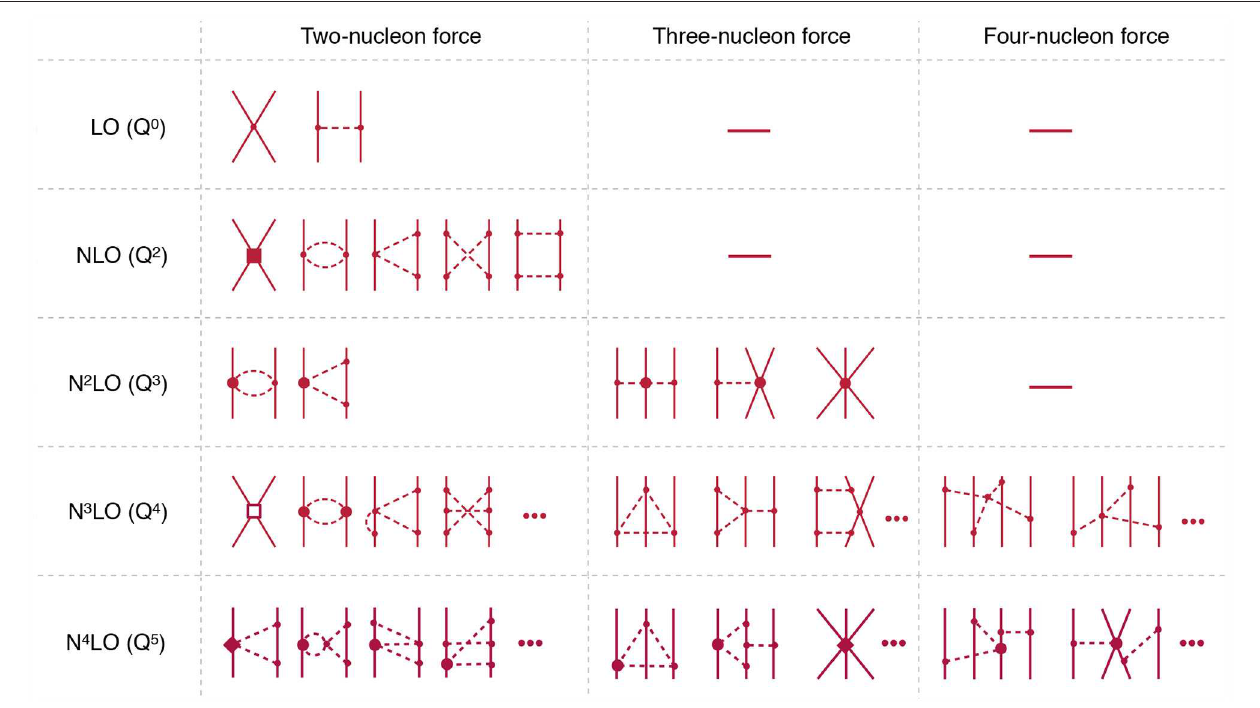
FIGURE 2 | Hierarchy of nuclear forces at increasing orders in chiral expansion in the Weinberg scheme. Solid and dashed lines refer to nucleons and pions, respectively. Solid dots, filled circles, filled squares, filled diamonds, and open squares refer to vertices from the Lagrangian in Equation (1) of dimension 1 and 4,